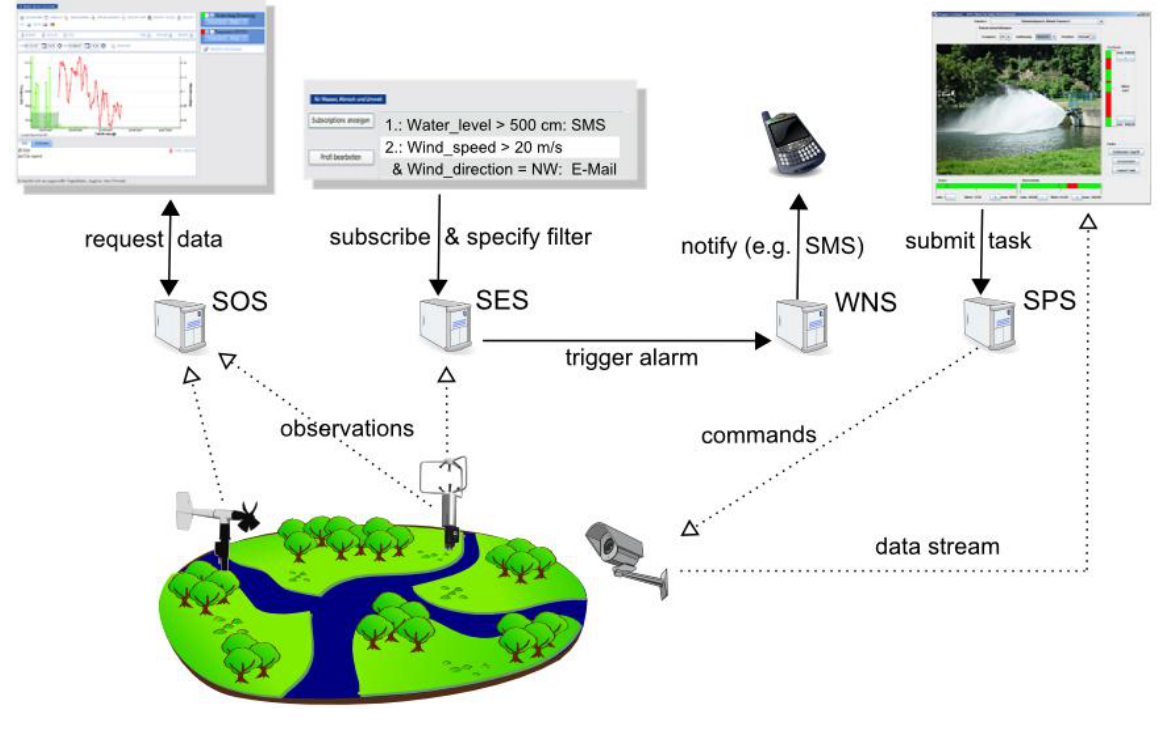
Figure 5. Deployment scenario for SWE